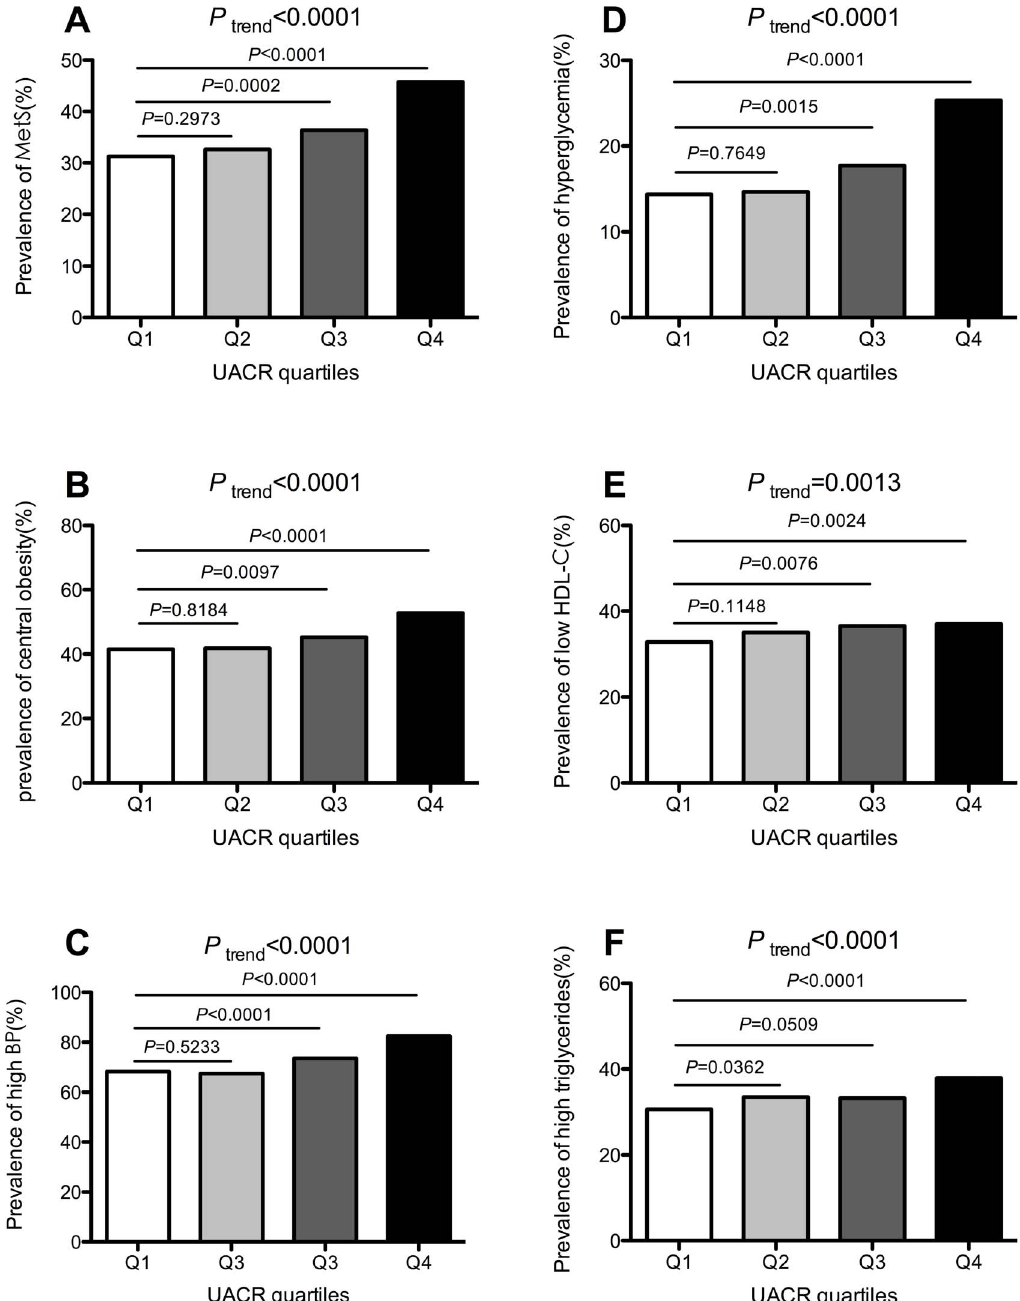
Figure 1. Prevalence of MetS (Panel A), central obesity (Panel B), high BP (Panel C), hyperglycemia (Panel D), low HDL-C (Panel E), high triglycerides (Panel F) in different UACR quartiles; UACR quartiles cut-off points for male: 0 mg/g , Q1 , 2.28 mg/g, 2.28 mg/g # Q2 , 3.67 mg/g, 3.67 mg/g # Q3 , 6.21 mg/g, 6.21 mg/g # Q4 , 30.00 mg/g; and for female: 0 mg/g , Q1 , 3.09 mg/g, 3.09 mg/g # Q2 , 5.22 mg/g, 5.22 mg/g # Q3 , 8.81 mg/g, 8.81 mg/g # Q4 , 30.00 mg/g); P values and P trend were calculated from CMH chi-square tests. Panel A : The prevalence was 31.3, 32.7, 36.4 and 45.7% for MetS from the lowest to the highest UACR quartile, respectively. Panel B : The prevalence was 41.5, 41.9, 45.2 and 52.8% for central obesity from the lowest to the highest UACR quartile, respectively. Panel C : The prevalence was 68.2, 67.3, 73.5 and 82.5% for high BP from the lowest to the highest UACR quartile, respectively. Panel D : The prevalence was 14.4, 14.7, 17.7 and 25.3% for hyperglycemia from the lowest to the highest UACR quartile, respectively. Panel E : The prevalence was 32.9, 35.0, 36.5 and 37.0% for low HDL-C from the lowest to the highest UACR quartile, respectively. Panel F : The prevalence was 30.6, 33.5, 33.3 and 37.9% for high triglycerides from th lowest to the highest UACR quartile, respectively.